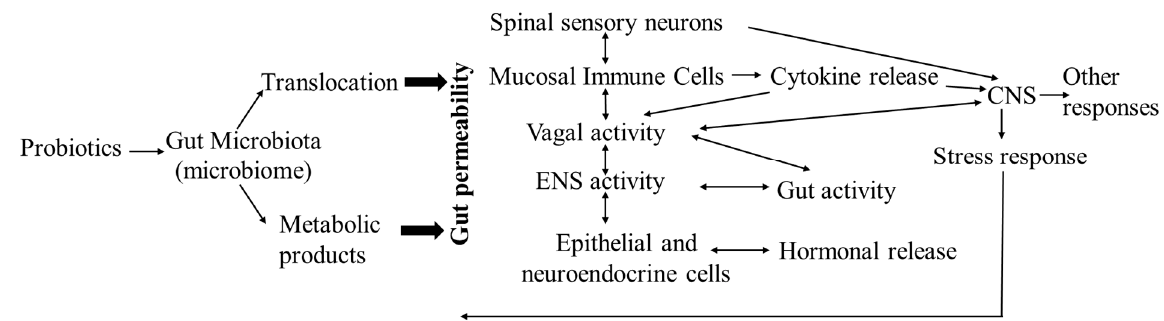
Figure 2. The effects of probiotics on the microbiota–host interaction at the level of the gastrointestinal mucosa via local neural, endocrine, and immune activities, influencing brain neurotransmitter expression, physiological homeostasis, and immunity, to regulate hosts’ stress responses (modified from Yarandi et al. [140]).